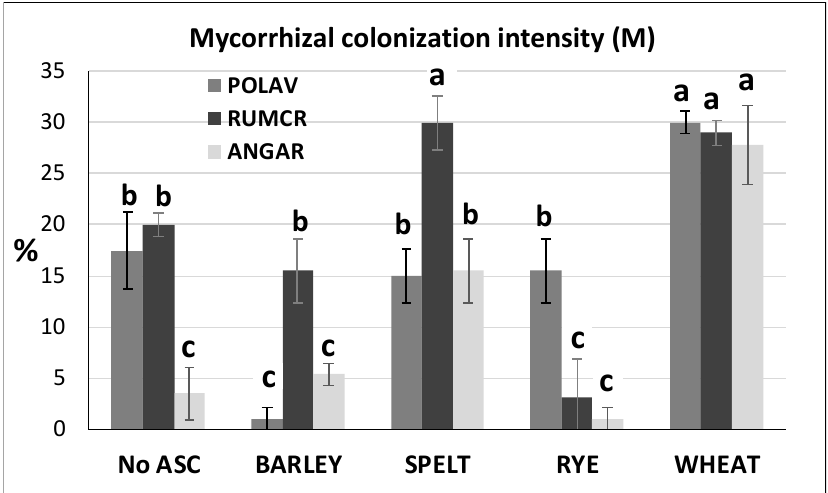
Figure 1. Mycorrhizal colonization intensity (M, in %) of Polygonum aviculare (POLAV), Rumex crispus (RUMCR) and Anagallis arvensis (ANGAR) in No ASC (control) and Yes ASC (barley, spelt, rye and wheat) systems, sampled at melon harvest (August 2014). Different letters represent significant differences (Tukey’s HSD test for means comparison).